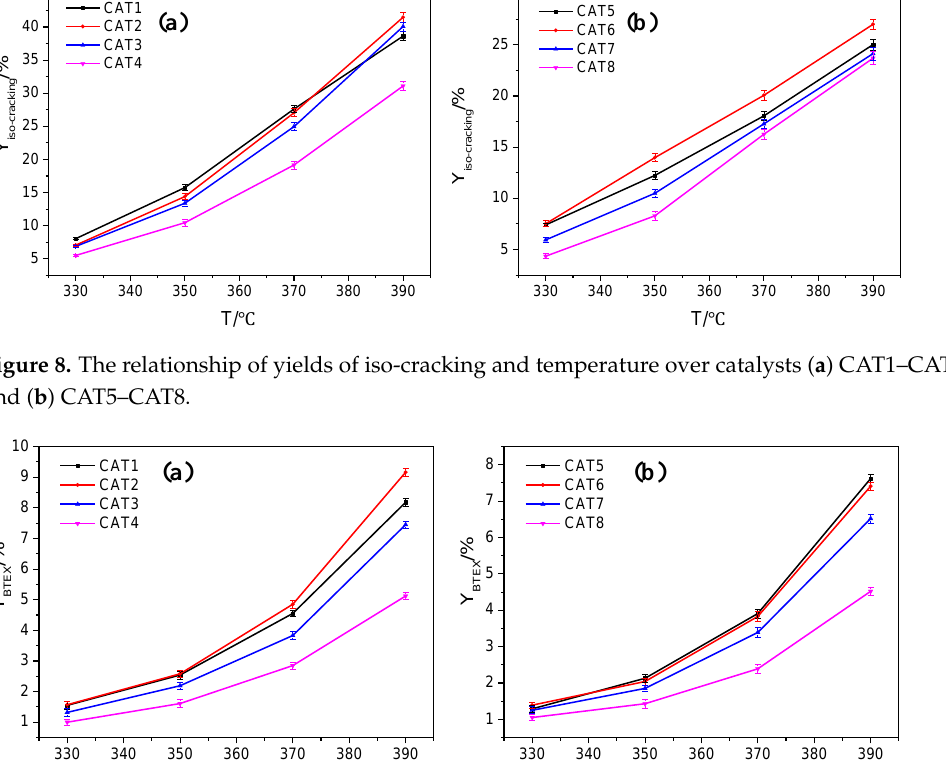
Figure 9. The relationship of yields of BTEX and temperature over catalysts ( a ) CAT1 – CAT4 and ( b ) CAT5 – CAT8.